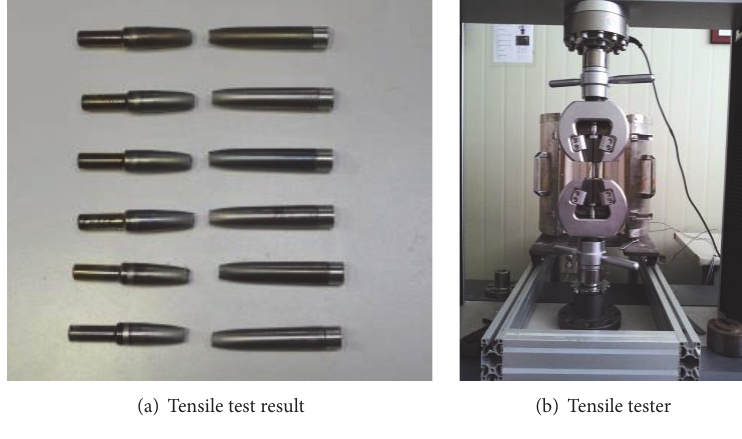
Figure 19: Tensile test of fuel